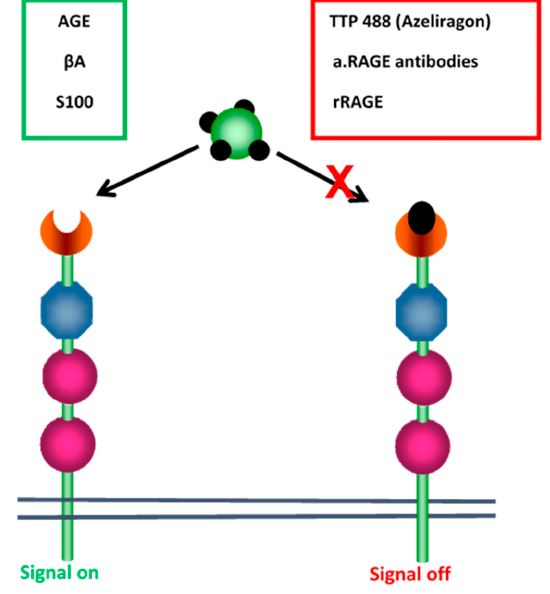
Figure 8. Blockade of RAGE activation. RAGE molecule has an extracellular part with two constant domains (pink circles) and one variable domain (blue octagon). The binding of AGE, β Amyloid protein and S100 calgranulins to RAGE region (brown) can be inhibited by anti-RAGE antibodies or a synthetic peptide TTP488. However, recombinant RAGE is able to bind the AGE ligands competing with the cellular RAGE. The blockade resulted in the absence of signal transduction in endothelial cells.